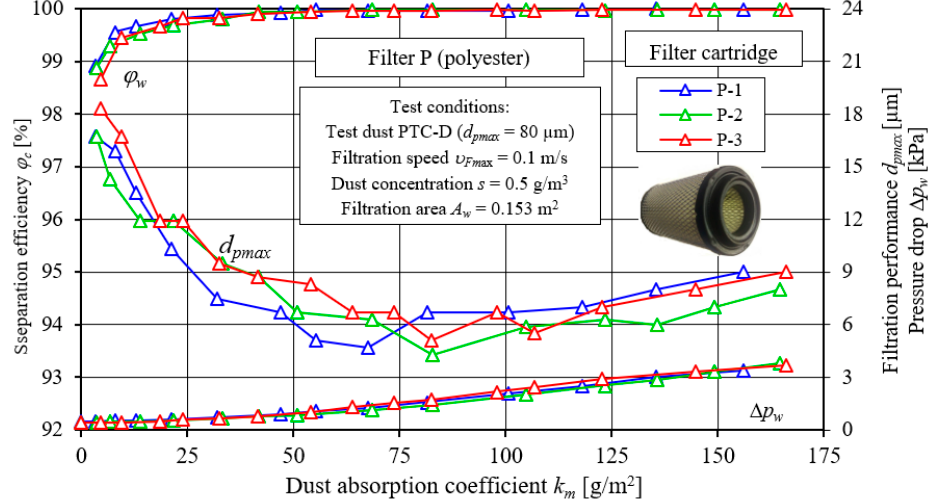
Figure 21. Characteristics of separation efficiency ( ϕ w ) and filtration performance ( d pmax ) and pressure